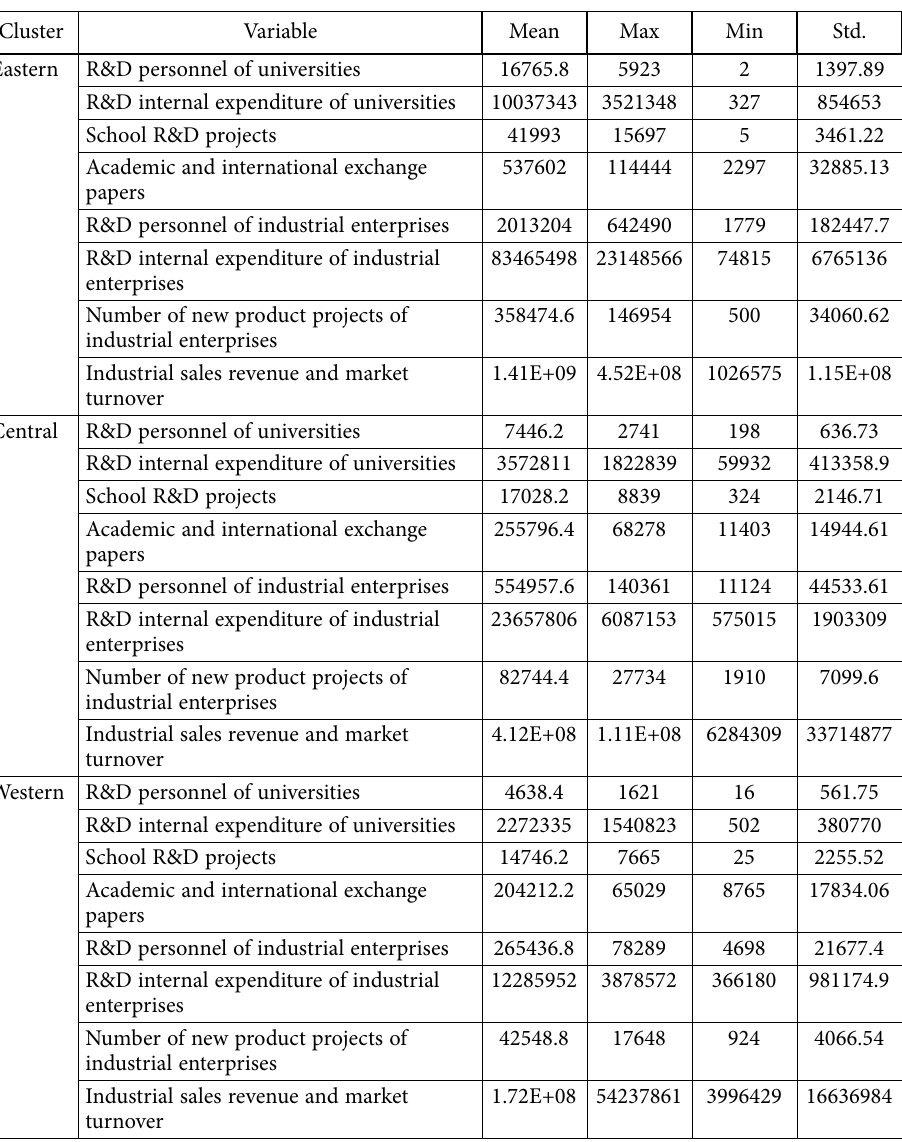
Table 3. Descriptive statistics of inputs and outputs